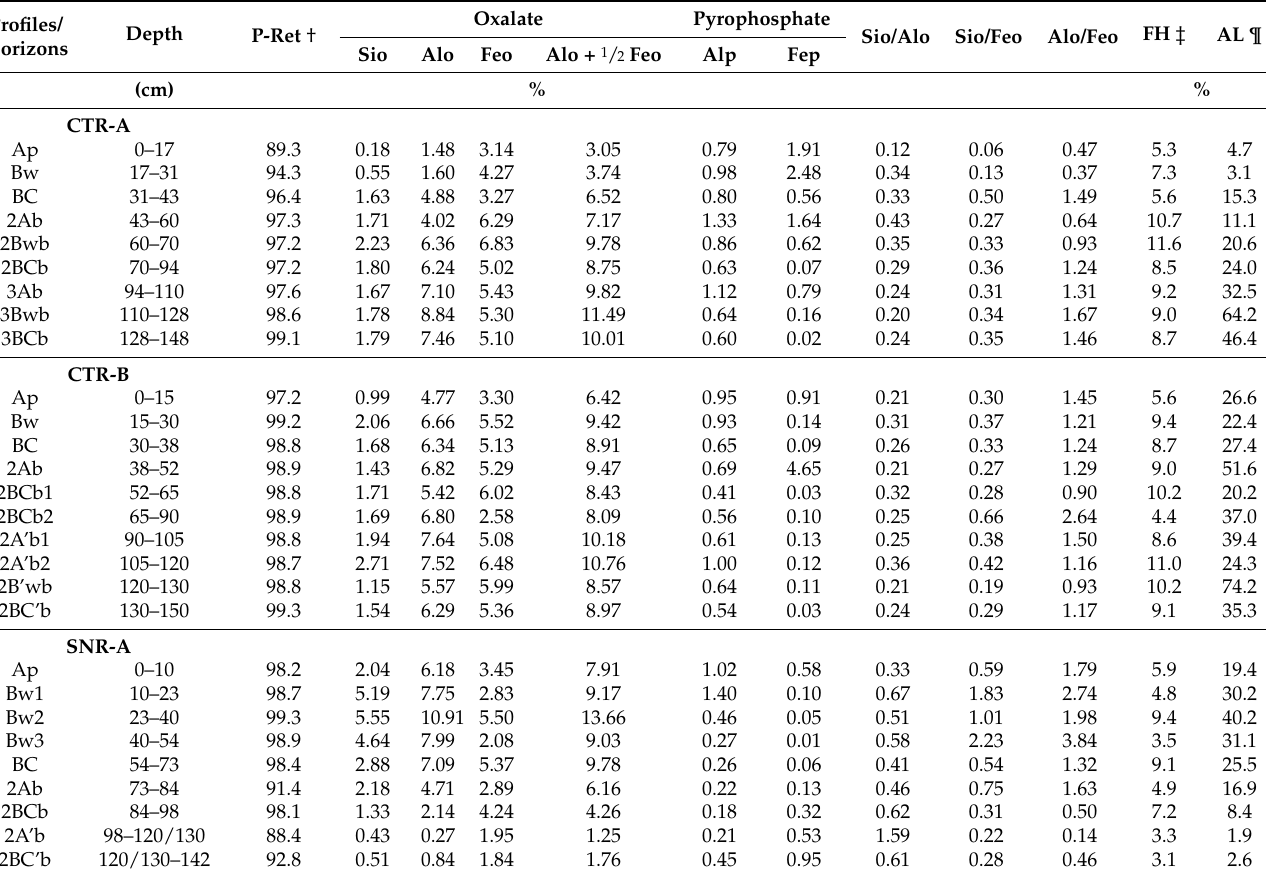
Table 6. P retention and amorphous material, organometal, ferrihydrite, and allophane contents of soils with different agro-climatic zones, of different types, and with different ages of parent